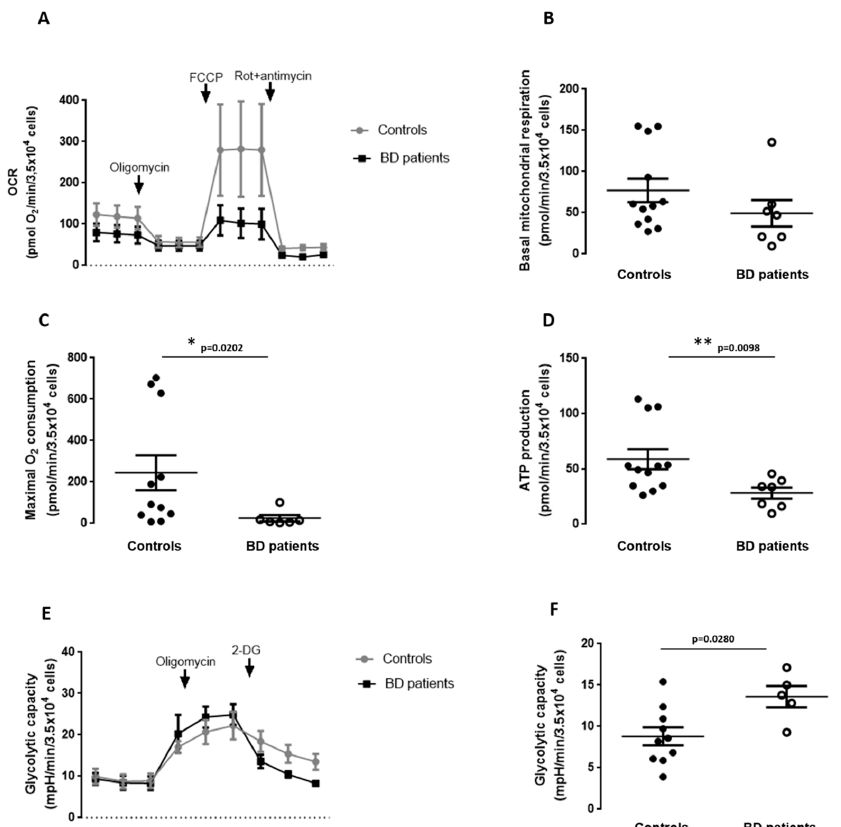
Figure 5. Mitochondrial respiration and glycolytic capacity in BD patients’ fibroblasts. Oxygen consumption rate (OCR) was evaluated in fibroblasts from BD patients and age-matched controls. ( A – F ) Mitochondrial respiration was assessed by sequential addition of oligomycin, FCCP and rotenone/antimycin A by using a Seahorse XF24 flux analyzer. ( A ) Repre- sentative traces depicting the average of n = 5 controls and n = 3 BD patients-derived fibroblasts. ( B ) Basal mitochondrial respiration, ( C ) maximal O 2 consumption and ( D ) ATP production values result from the subtraction of each parameter with the first value of OCR after rotenone+antimycin injection. Data are the mean ± SEM expressed in absolute values of five different control individuals and three BD patients after the correction with non-mitochondrial OCR provided by the injection of rotenone+antimycin. ( E , F ) Glycolytic capacity was assessed by sequential addition of oligomycin and 2-deoxyglucose (2-DG). ( E ) Representative traces and ( F ) glycolytic capacity. Data are the mean ± SEM expressed in absolute values of five different control individuals and 3 BD patients after the correction with non-glycolytic ECAR provided by the injection of 2-deoxyglucose. Experiments were carried out in duplicate. * p < 0.05; ** p < 0.01, significantly different from control group, as determined by Mann–Whitney non-parametric